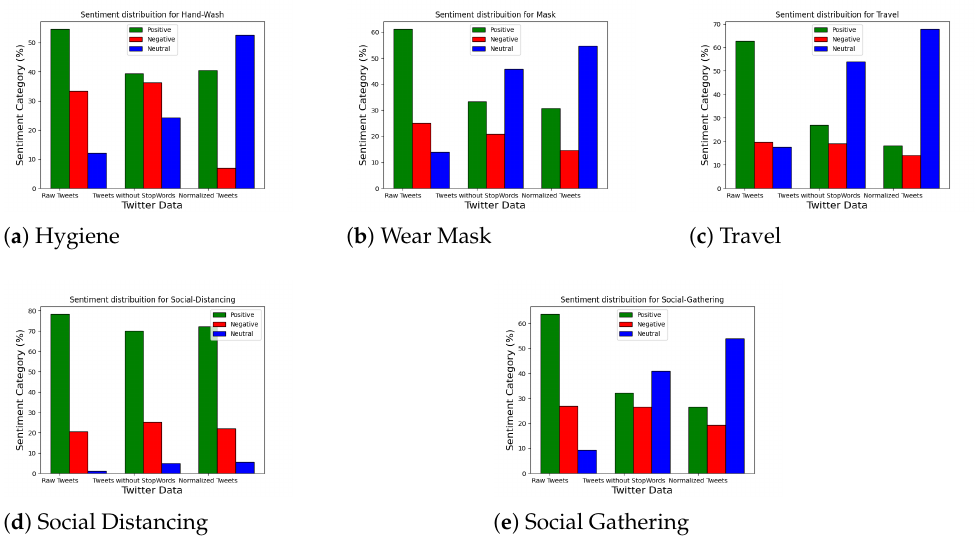
Figure 9. Sentiment percentage distribution using raw and pre-proceseed tweets for Twitter Dataset 2 on healthy lifestyle.